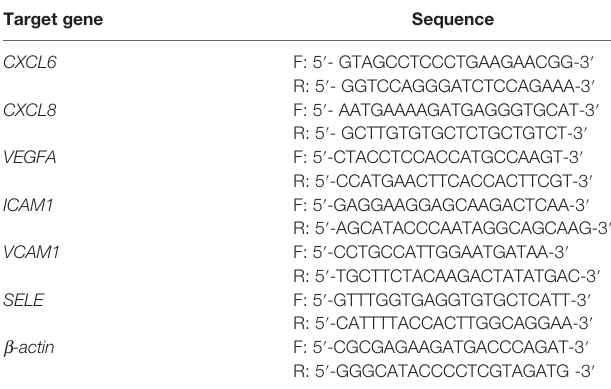
TABLE 1 | Primers used for the polymerase chain reaction. Target